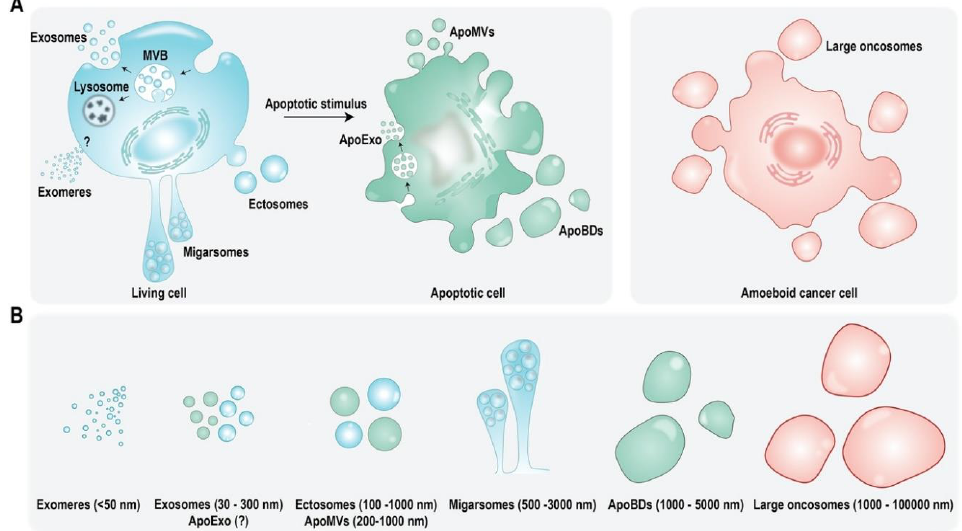
Figure 1. Schematic representation of EV subtypes identified in eukaryotic cells. ( A ) Although live cells were initially thought to shed exosomes and microvesicles, recent developments have identified novel EV subtypes including exomeres and migrasomes, whereas cancer cells also partake in secretion of large oncosomes. On the contrary, apoptotic cells which were long though to shed only ApoBDs are now known to secrete other EV subtypes including ApoMVs and ApoExos.